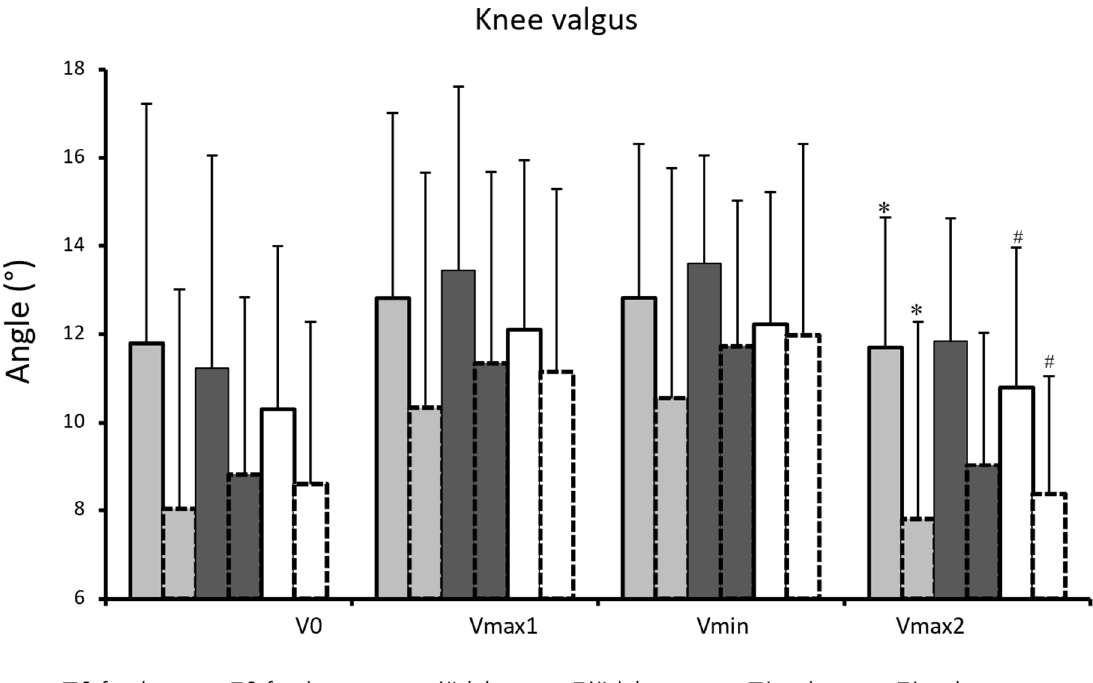
Figure 3. Mean (±SD) torso, hip extension, knee extension, and ankle flexion angle at the events v max1 , v min , and v max2 for the high-bar, low-bar, and safety-bar squat during 3-RM. * indicates a sig- nificant difference between this squat condition and all other squat conditions on a p ≤ 0.05 level. # indicates a significant difference between this squat condition and the low-bar condition on a p ≤ 0.05 level. † indicates a significant difference between this squat condition and low-bar condition on a p ≤ 0.05 level.